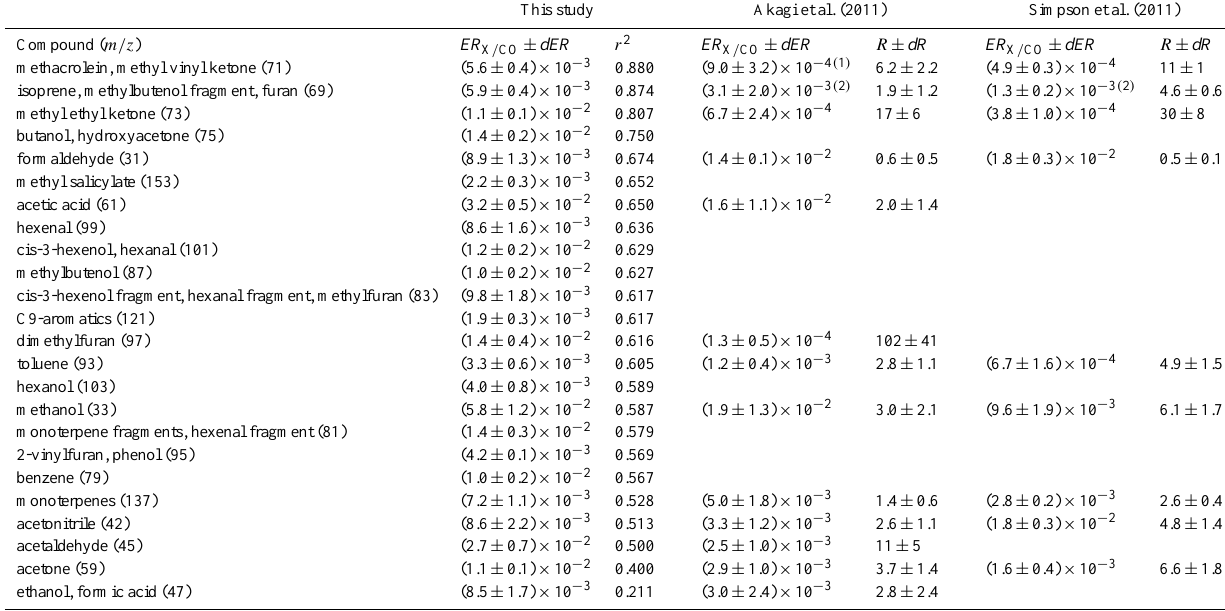
Table 3. Emission ratios of VOCs ( 1 X) and their standard errors (s.e.) obtained from a linear regression of 1 X vs. the excess carbon monoxide concentration 1 CO. The data are sorted according to the squared correlation coefficient r 2 . For comparison, the respective ratios are calculated from the emission factors of Akagi et al. (2011) and Simpson et al. (2011). R ± dR : the ratio of the emission ratio in the present study to that presented by Akagi et al. (2011) and Simpson et al.